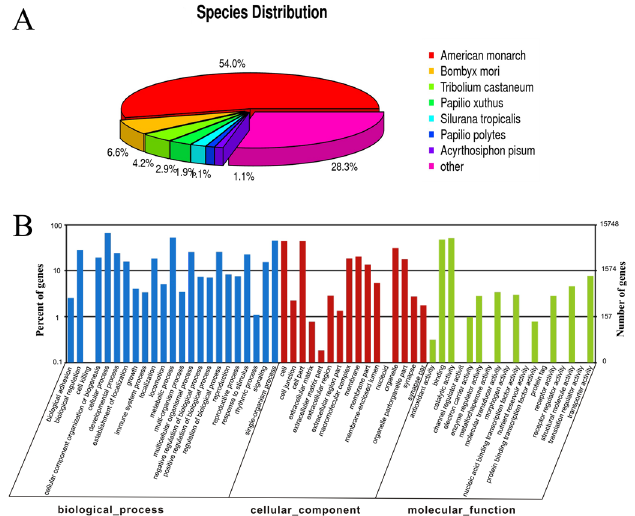
Fig 1. Annotation summary of C . medinalis antenna unigenes. (A) Species distribution of unigenes ’ best- hit annotation term in the nr database (B) Gene ontology classifications of the C . medinalis